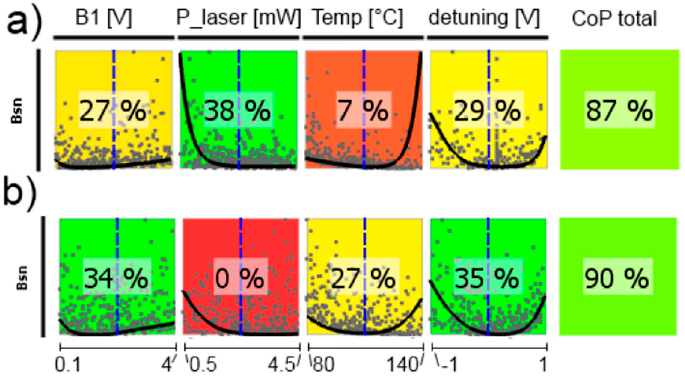
Figure 15. CoP matrix of the difference signals’ steepness near the Larmor frequency. ( a ) high-pressure magnetometer; ( b ) medium-pressure magnetometer. Approximation technique: isotropic kriging.